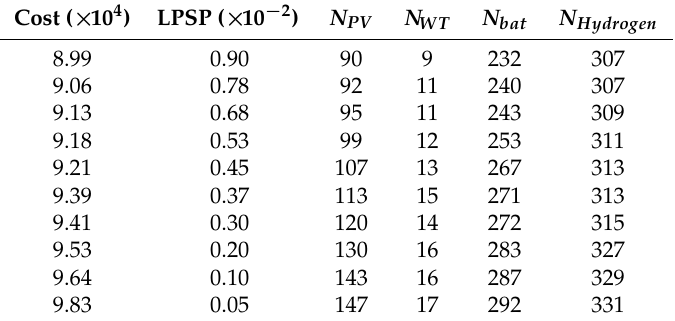
Table 2. Simulation